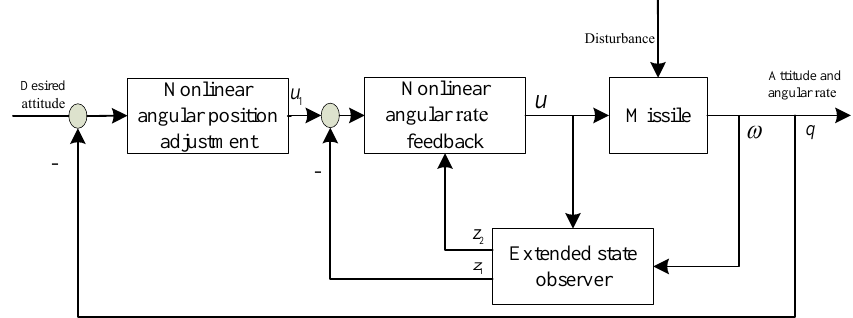
Figure 1. Structure of attitude control